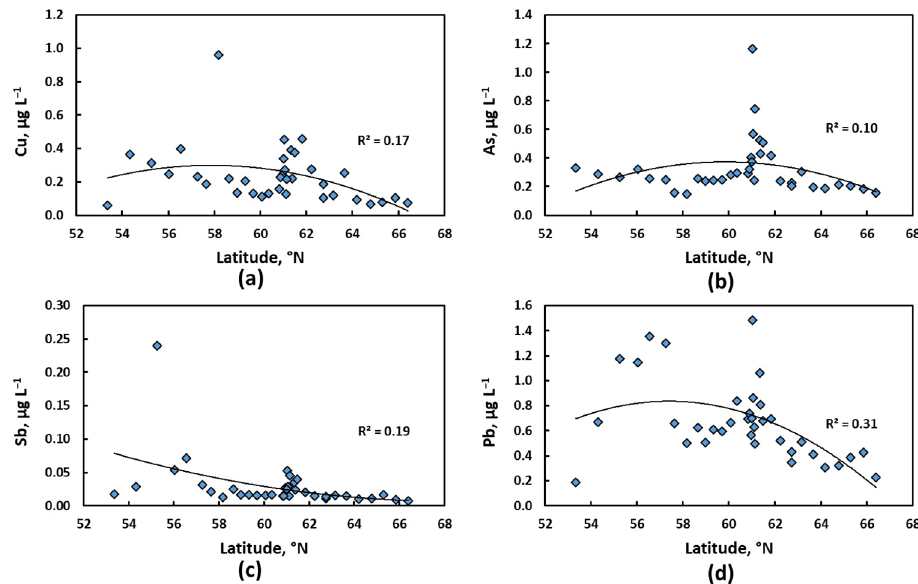
Figure 3. Examples of dissolved (<0.22 µm) metal concentrations in snow water as a function of latitude in the WSL. Cu ( a ); As ( b ); Sb ( c ); Pb ( d ).